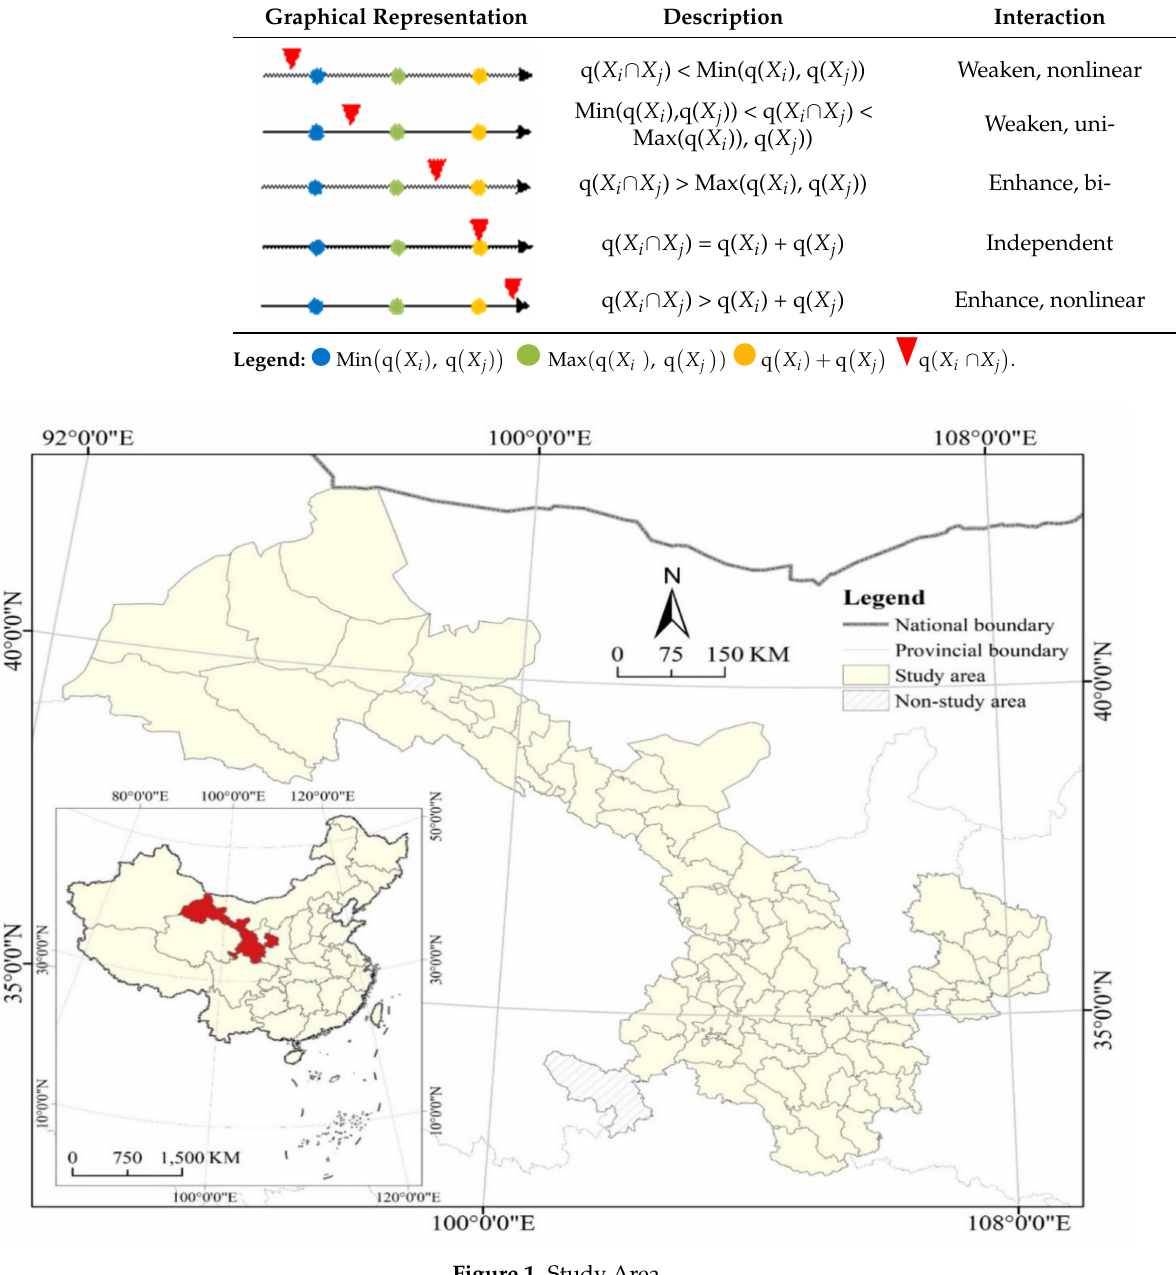
Table 1. Interaction between Explanatory Variables.